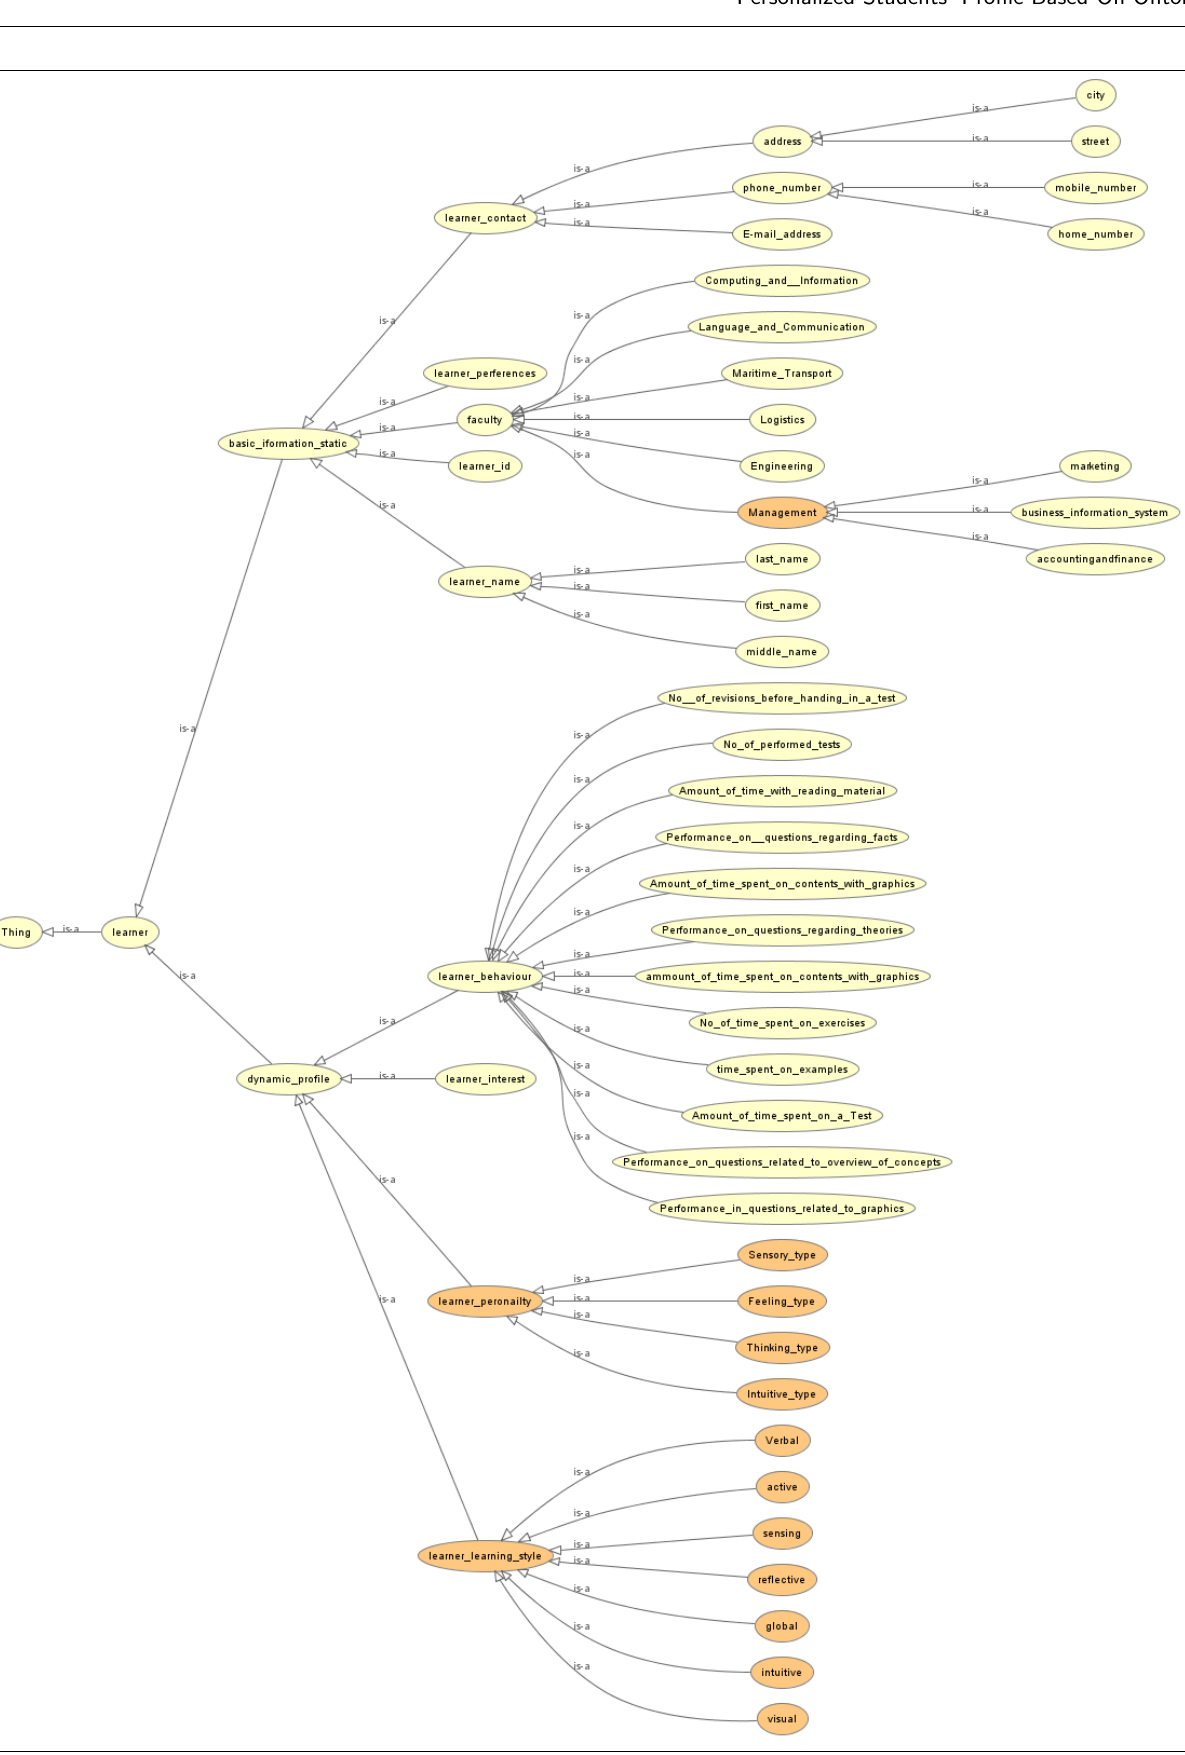
Figure 9. Ontology